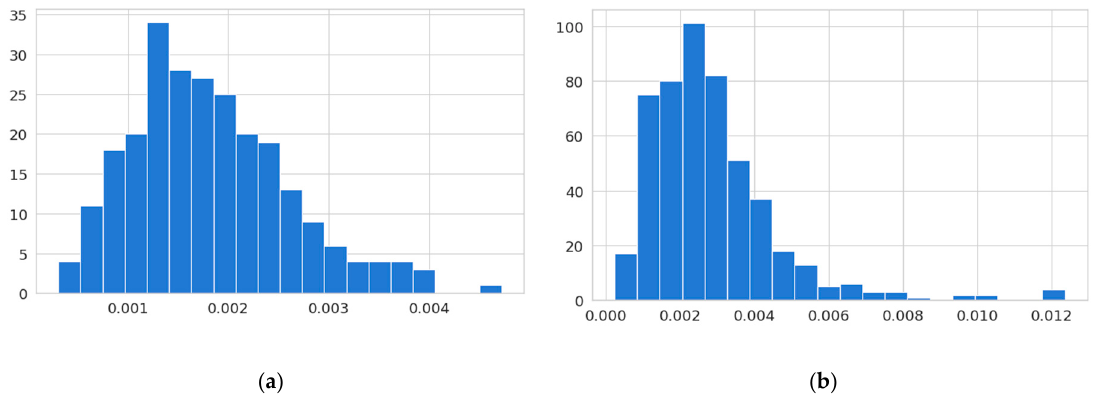
Figure 4. Reconstruction error for the evaluation images: ( a ) positives, ( b ) negatives.